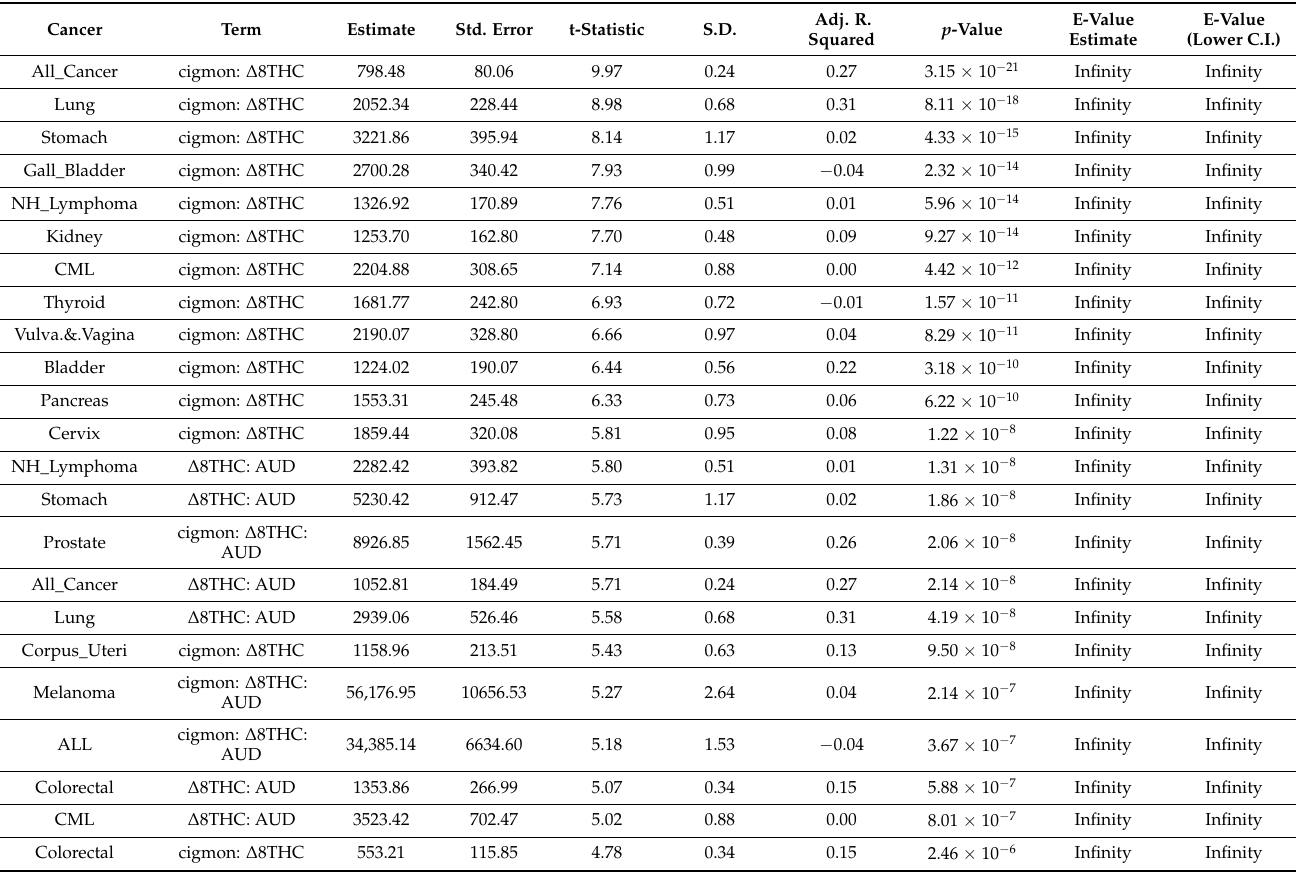
Table 2. The positive significant terms including ∆ 8THC from the interactive panel model.